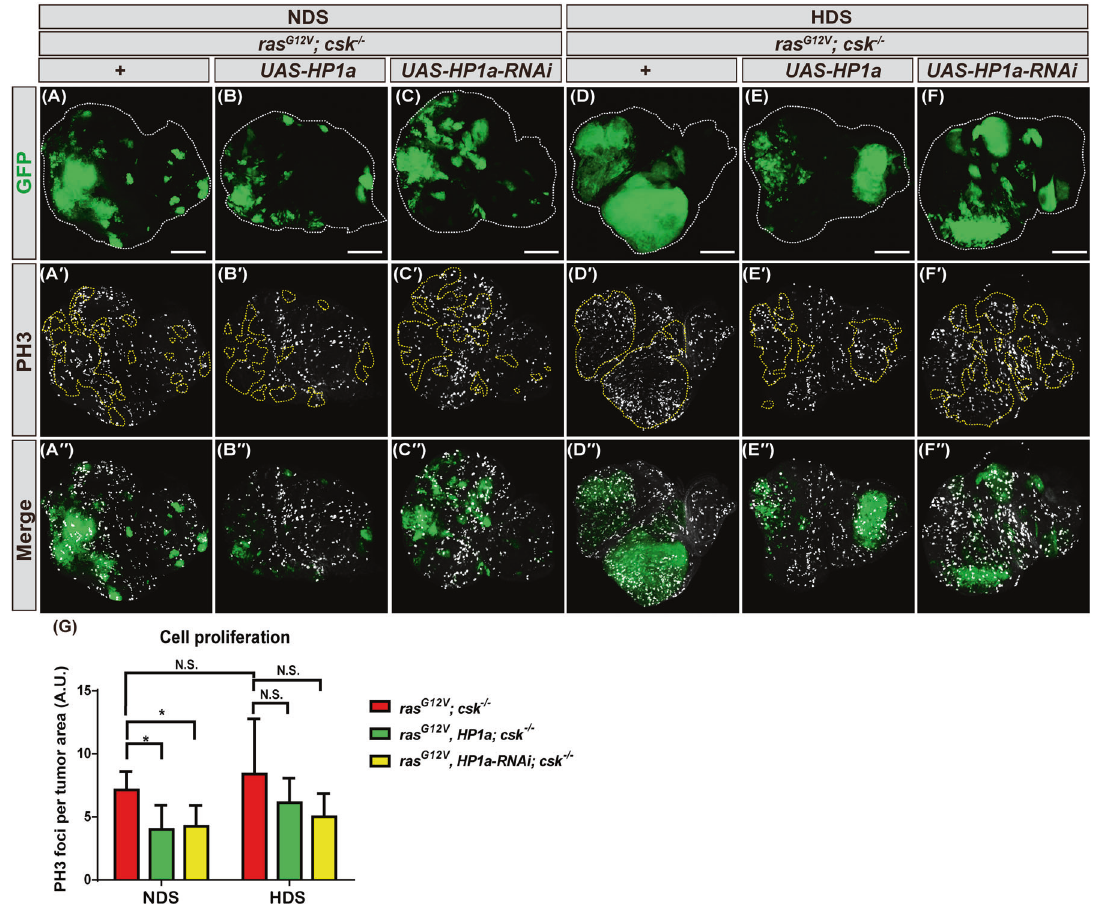
Fig. 4 Increased heterochromatin formation reduces proliferation of tumor cells from fl ies fed NDS. Third instar eye discs of ras G12V ; csk − / − and ras G12V , HP1a; csk − / − and ras G12V , HP1a-RNAi; csk − / − fl ies fed NDS or HDS with GFP-labeled tumor cells (green) and PH3 immunostaining (gray). Scale bar: 100 μ m. A – A ′′ , D – D ′′ ras G12V ; csk − / − . B – B ′′ , E – E ′′ ras G12V , HP1a ; csk − / − . C – C ′′ , F – F ′′ ras G12V , HP1a-RNAi ; csk − / − . G Fluorescent quanti fi cation of PH3 puncta in tumor cells from ras G12V ; csk − / − and ras G12V , HP1a; csk − / − and ras G12V , HP1a-RNAi; csk − / − fl ies fed NDS or HDS. All results analyzed and presented re fl ect data from three independent experiments ( n = 15). Results are shown as mean ± SD of individual eye discs. Asterisk indicates a statistically signi fi cant difference (* p < 0.05). GFP green fl uorescent protein, HDS high dietary sugar, NDS normal dietary sugar, NS not signi fi